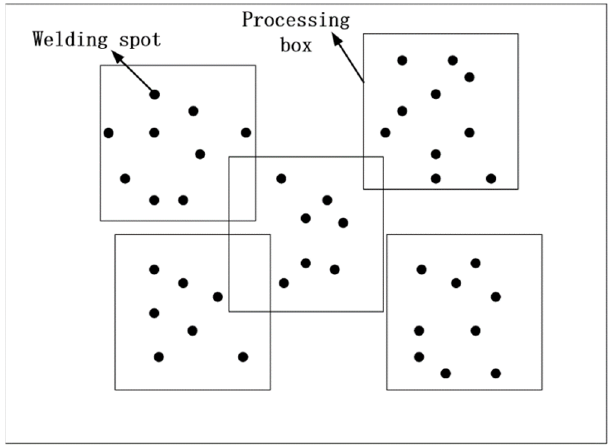
Figure 2. Schematic diagram of full coverage of solder joints.